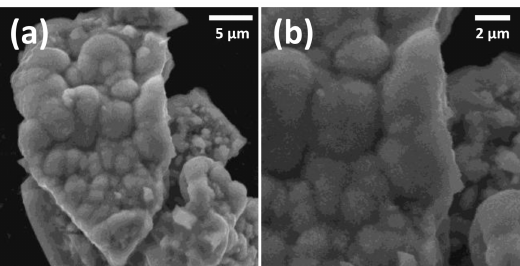
Figure 2. SEM image showing morphology of the nanopowders of LiAl(IO 3 ) 4 at two different magnifications. White bars in the figures indicate the scale, respectively ( a ) 5 µ m, and ( b ) 2 µ m.